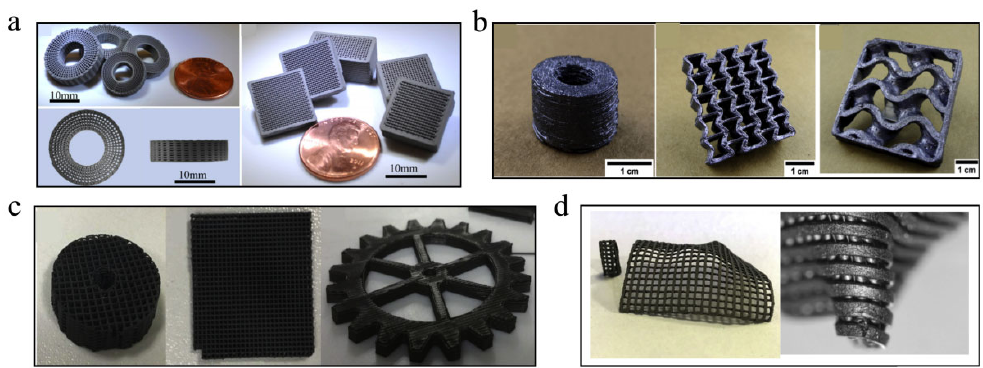
Fig. 19 Robocasting of SiC ceramic: (a) Robocasting + SPS. Reproduced with permission from Ref. [67], © The American Ceramic Society 2012. (b) Robocasting + pressureless sintering. Reproduced with permission from Ref. [68], © Elsevier Ltd. 2019. (c) Robocasting manufactured ultra-high temperature ceramic. Reproduced with permission from Ref. [69], © Elsevier Ltd. 2019. (d) Robocasting manufactured α -SiC/B 4 C ceramic. Reproduced with permission from Ref. [70], © Elsevier Ltd.